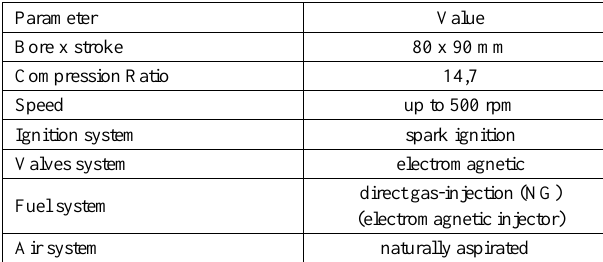
Fig. 2. Diagram of the test stand setup with instrumentation [11] Table 1. Rapid compression machine parameters